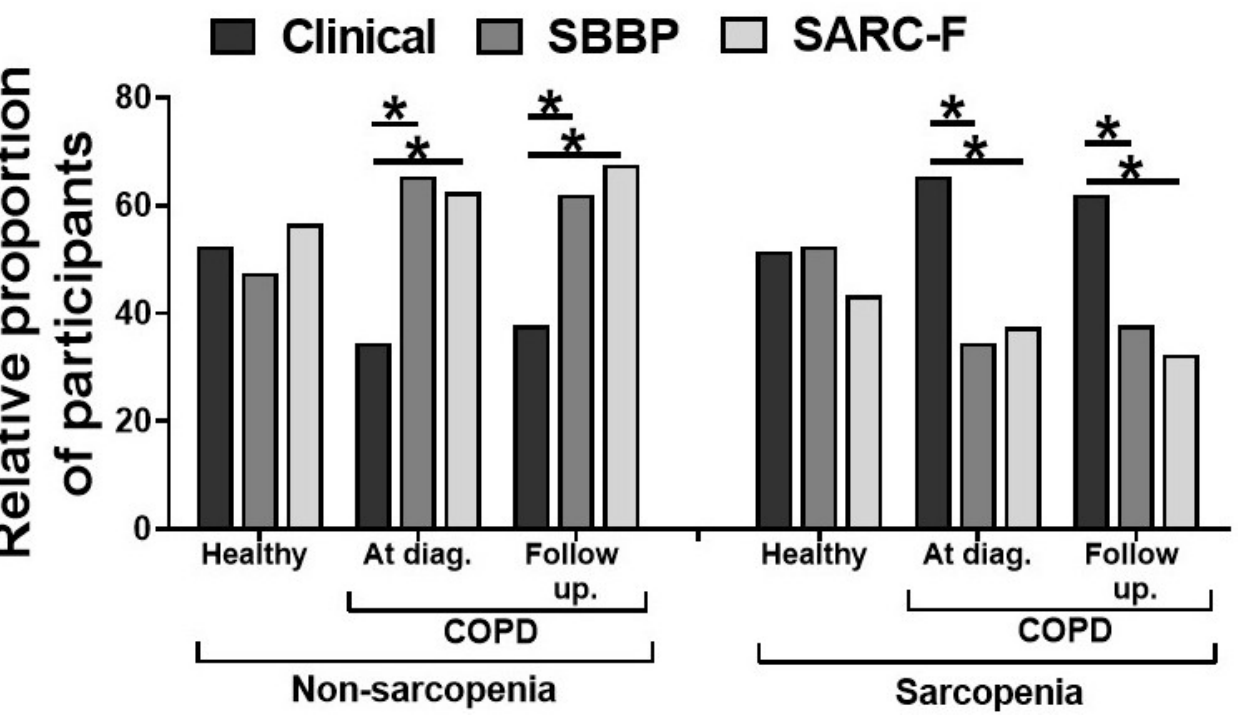
Figure 2. The relative proportion of sarcopenia as defined clinically, by short physical performance battery score ( ≤ 8) and the SARC-F score ( ≥ 4) in healthy controls and patients with COPD at diagnosis and following pulmonary rehabilitation ( n = 77–84/group). Values are expressed in percentages, * p < 0.05.